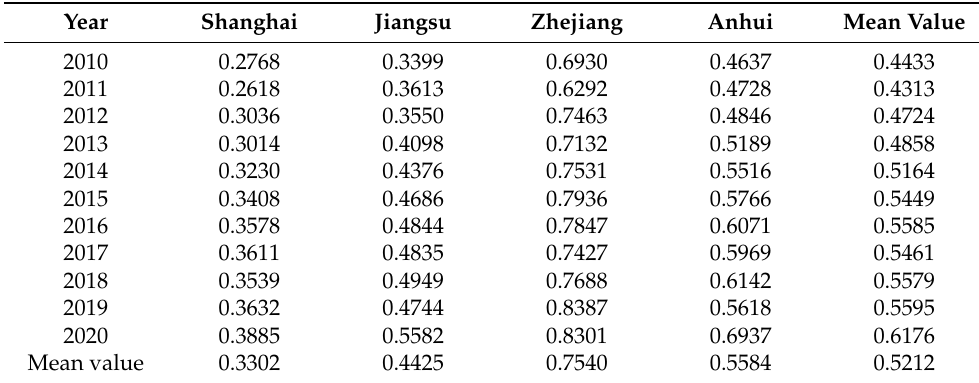
Table 5. Level of eco-environmental quality in the